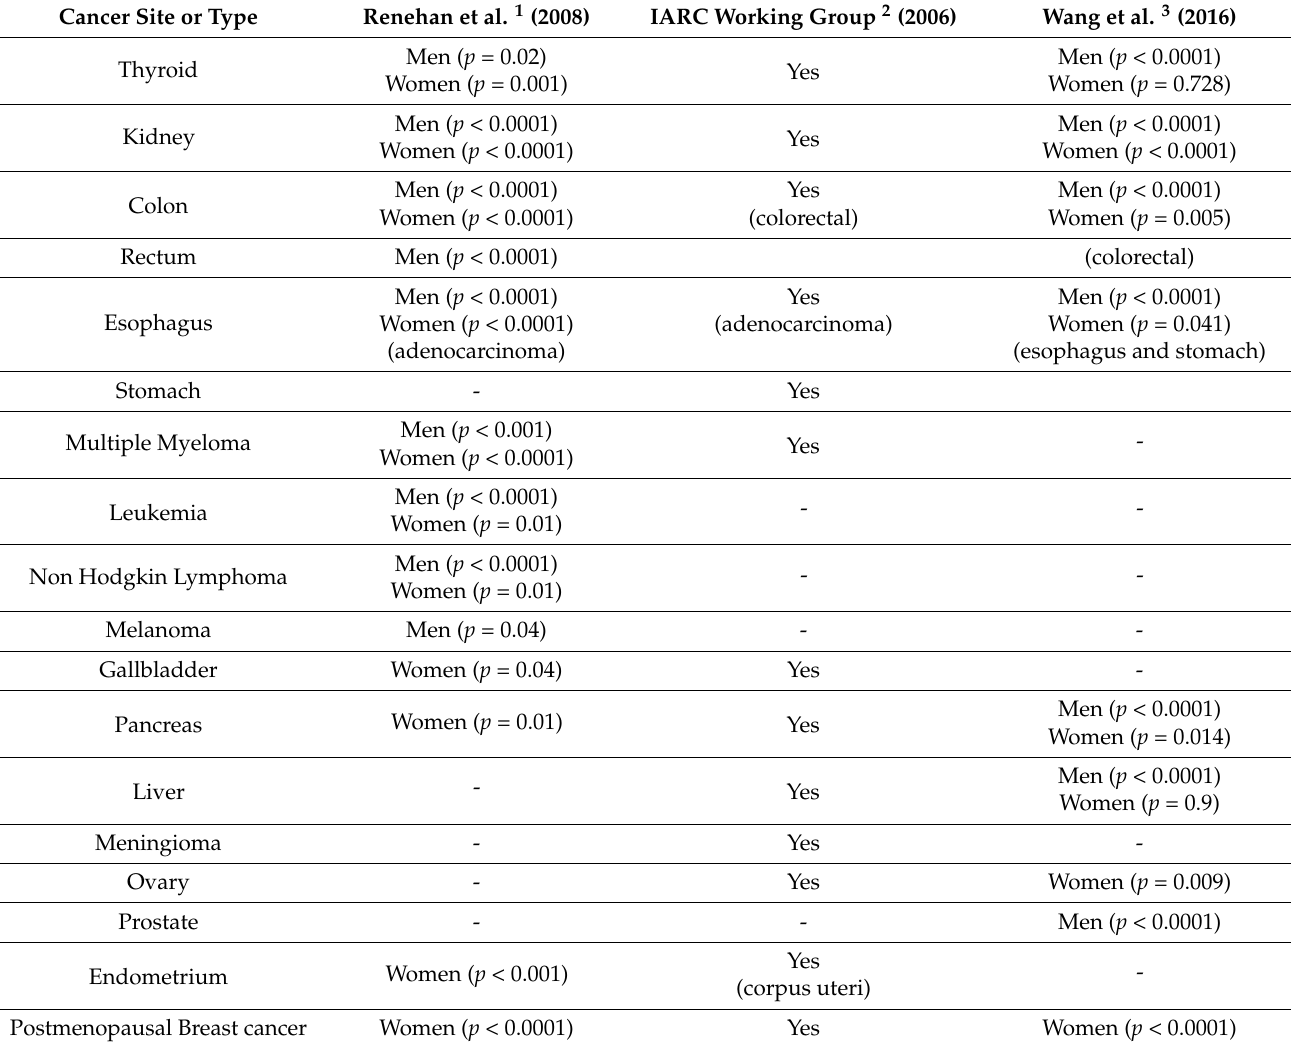
Table 1. Summary of evidences for increased cancer risk in